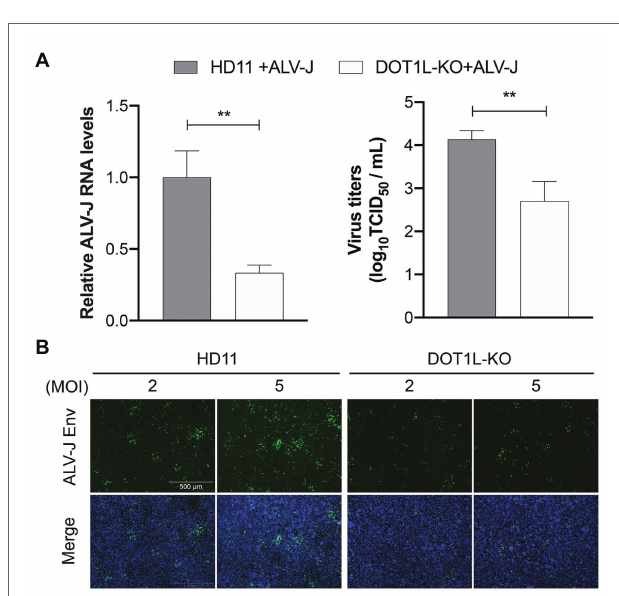
FIGURE 4 | Knockout of DOT1L inhibits ALV-J replication. (A) HD11 and DOT1L-KO cells were infected with ALV-J (MOI 2). After 48 h, the viral RNA levels were measured by qRT-PCR. GAPDH mRNA level was measured as an internal control (left panel). The supernatants were collected to measure the viral titers by a standard TCID 50 method (right panel). (B) Immunofluorescence analyses of ALV-J Env protein. HD11 cells and DOT1L-KO cells were infected with ALV-J at indicated MOI for 48 h, the cells were then visualized with the inverted fluorescence microscope and a specific antibody to the ALV-J Env protein (green), and nuclei were stained with 4 ' , 6-diamidino-2-phenylindole (DAPI; blue). Images show a representative image. All the data were shown as mean ± SD (error bars) from three independent experiments. ** p < 0.01; unpaired, two-tailed Student’s t